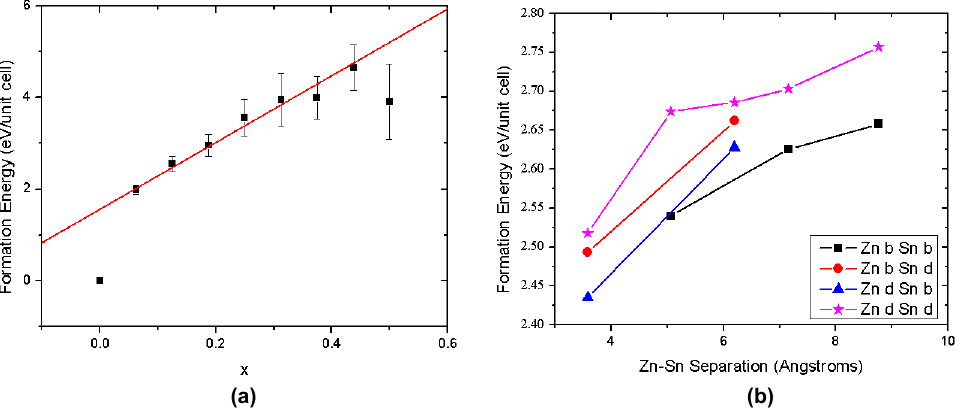
Figure 2. Formation energies as a function of ( a ) cosubstitution amounts of Zn x In 2 − 2x Sn x O 3 and ( b ) Zn-Sn separation for different site occupancies (i.e., “Zn b Sn b” represents Zn and Sn present on the b site). The linear fit in ( a ) is for 0 < x < 0.5. All values in ( a , b ) are normalized to the − 449.832 eV of In 2 O 3 ( x = 0), thus the greater values have less favored formation energies.